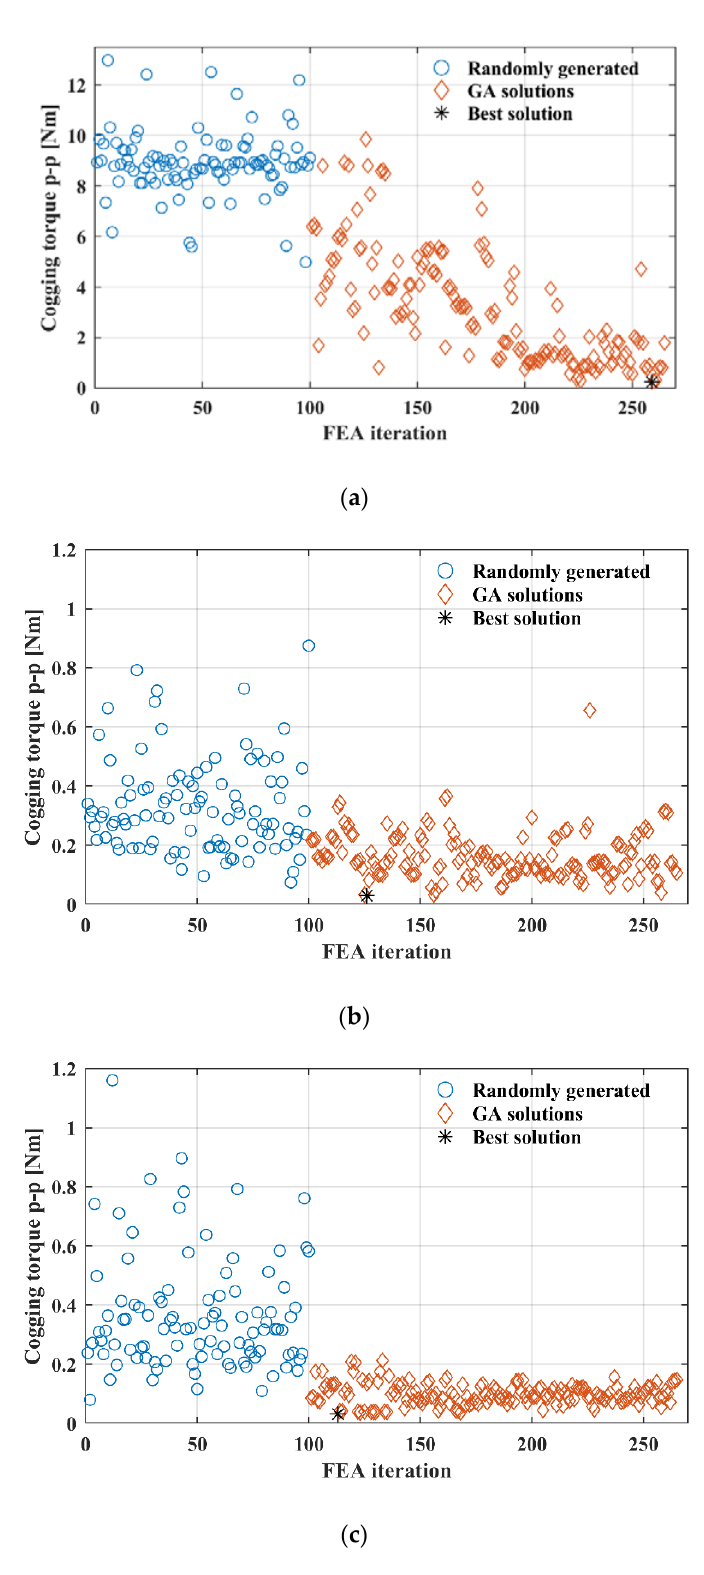
Figure 8. Objective function values computed using the TWM FEA performed during the heuristic procedure. ( a ) APMM with 20 stator segments. ( b ) APMM with 30 stator segments. ( c ) APMM with 60 stator segments.